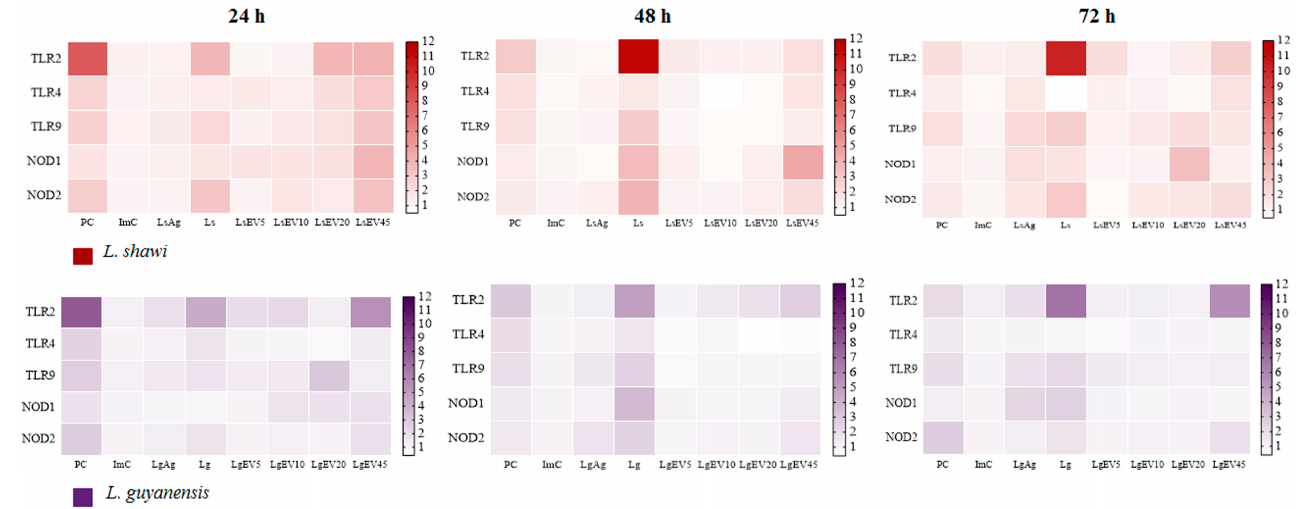
Figure 7. Effect of L. shawi and L. guyanensis EVs on TLR2, TLR4, TLR9, NOD1, and NOD2 gene expression. M Φ incubated for 24 h, 48 h, and 72 h with 5 (LsEV5; LgEV5), 10 (LsEV10; LgEV10), 20 (LsEV20; LgEV20), and 45 µ g · mL − 1 (LsEV45; LgEV45) of EVs from L. shawi (red) and L. guyanensis (purple), parasite antigens (LsAg and LgAg), and L. shawi (Ls) and L. guyanensis (Lg) promastigotes were analyzed by RT-qPCR. Results normalized to resting M Φ of three independent assays performed in triplicate are represented by heat maps. PC—positive control (M Φ incubated with PMA); ImC—M Ф incubated with negative control of EV isolation method.